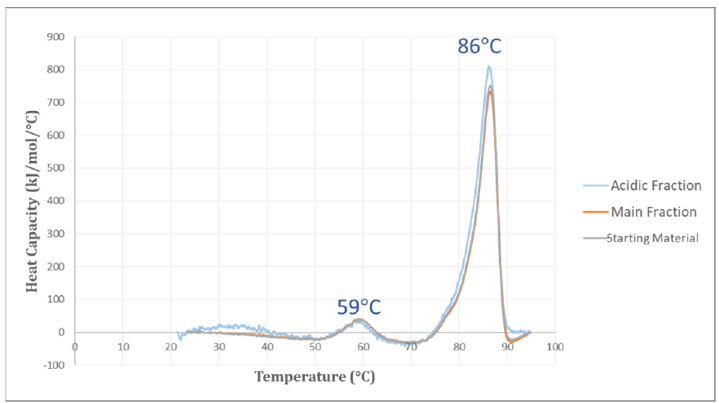
Figure 4. DSC Thermograms of the mAb1 acidic fraction ( blue ), the main fraction ( mango ), and the starting material ( grey ).